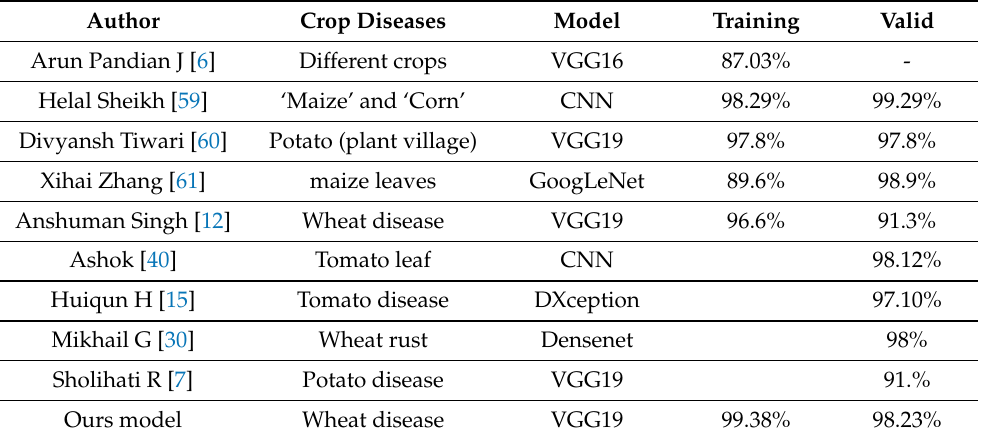
Table 2. Comparison of the proposed model accuracy with other